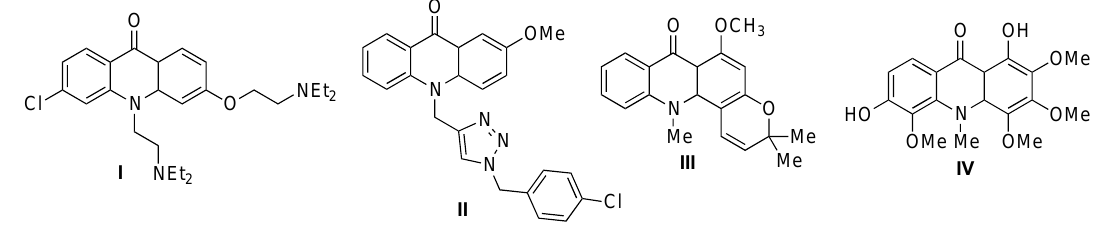
Figure 1. Selected bioactive 9-acridones.